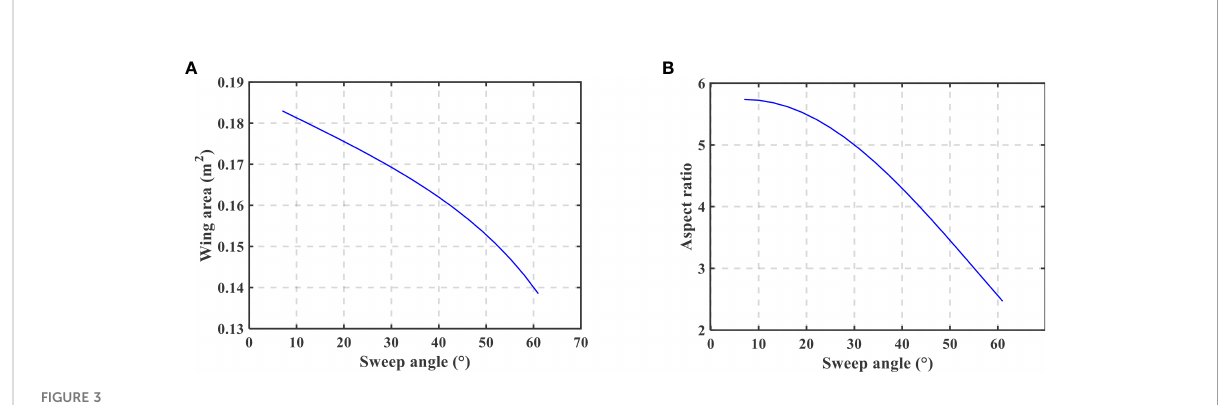
Figure 5. The origin of inertial frame is fi xed to the initial location of UG on the sea surface, in which the motion trajectory of UG can be expressed. The direction of the X -axis is same as the initial heading of UG on the sea surface, and the direction of the Z -axis is vertically downward with the sea surface. The origin of the body frame is fi xed to the center of buoyancy. The direction of the x -axis is coincident with that of the axis of UG, and the direction of the z -axis is vertically downward with the x -axis. As for the velocity frame, the origin of it coincides with the body frame and the O ’ -x ’ axis points to the velocity direction of UG. The O ’ -z ’ axis is vertically downward with the O ’ -x ’ axis, which is in the plane O - xz . Other axes are determined by right-hand rule.